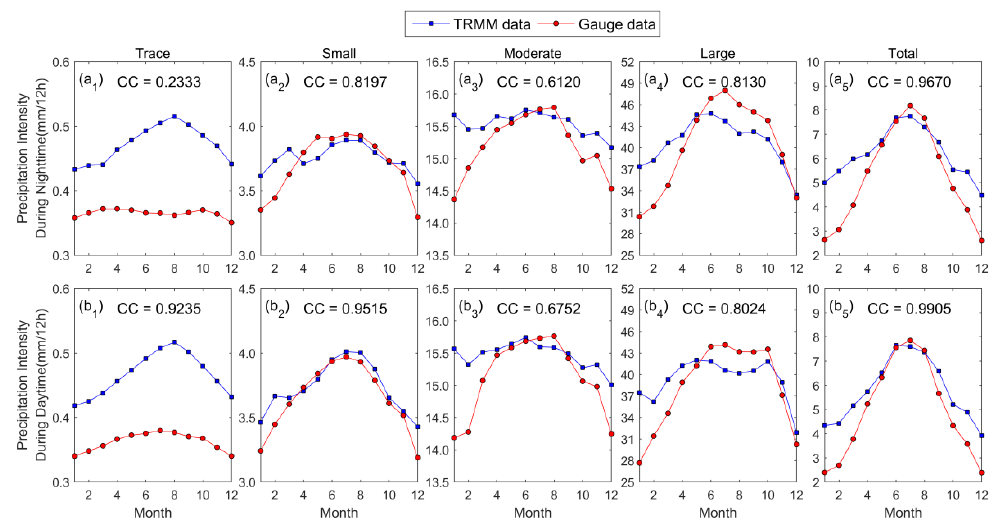
Figure 6. As in Figure 5, but for the intensity of precipitation. The y -axis scales are different for different precipitation categories.